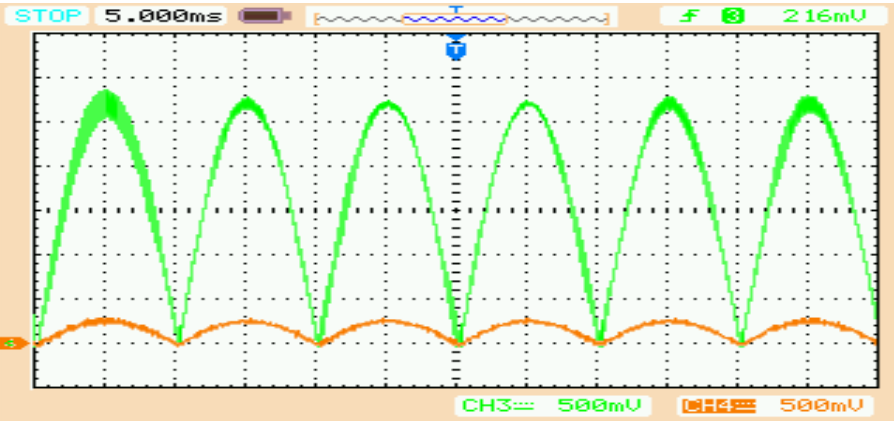
Figure 24. Inductor (1st and 3rd) current profiles for different inductor values of converters.